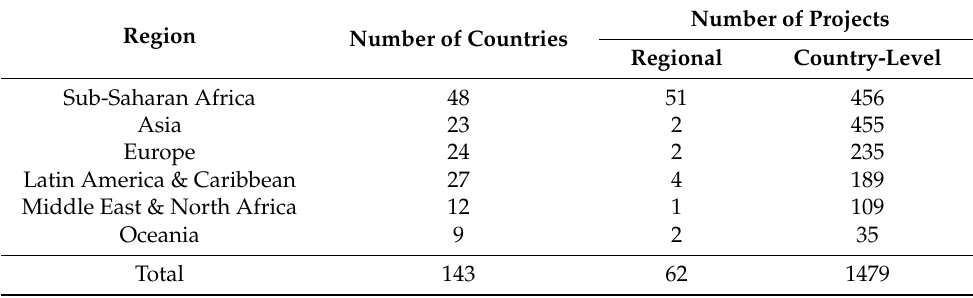
Table 2. Data composition by